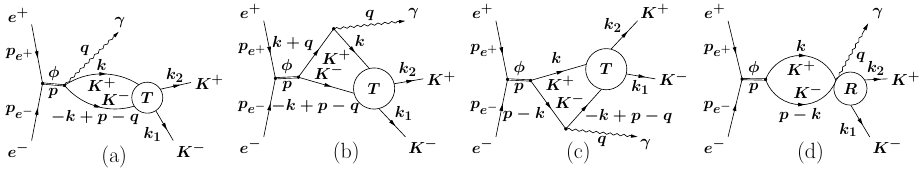
Figure 1. Diagrams for the reaction e + e − → K + K − γ with final-state K + K − interaction. The K + K − elastic amplitude is labelled by T and R denotes the di ff erence of the K + K − amplitudes T in Eq.